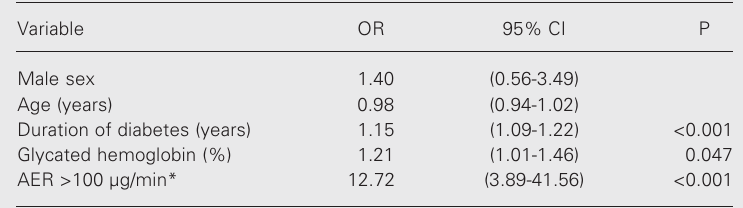
Table 2. Relationships between various clinical factors and the presence of diabetic